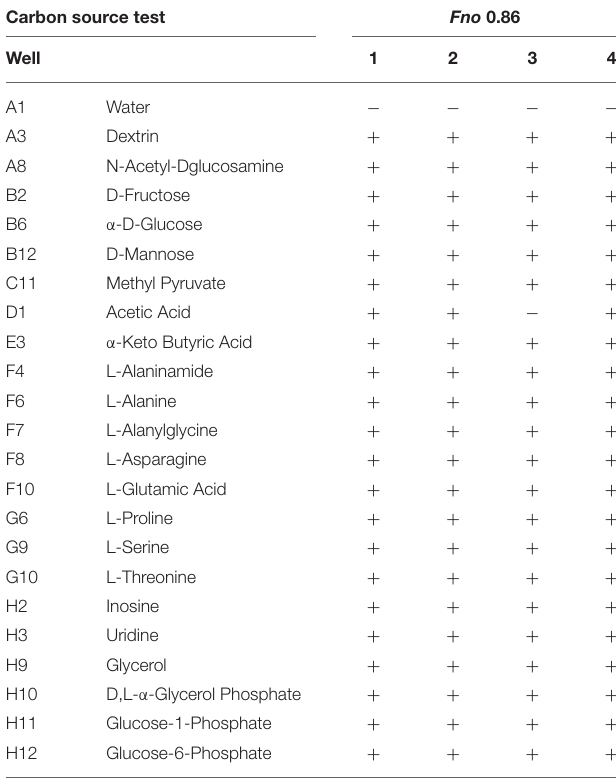
TABLE 4 | Metabolic fingerprint of the different Fno isolates at an OD 600 of